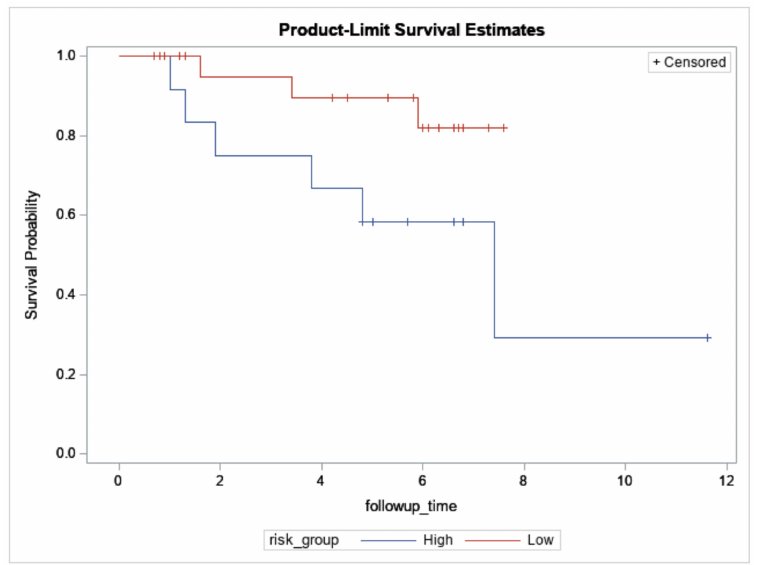
Figure 2. Overall survival of 12 high- and 26 low-risk Taiwanese breast cancers predicted by the concurrent genes signature who also underwent targeted sequencing. X-axis: Follow-up time in years. Y-axis: survival probability.